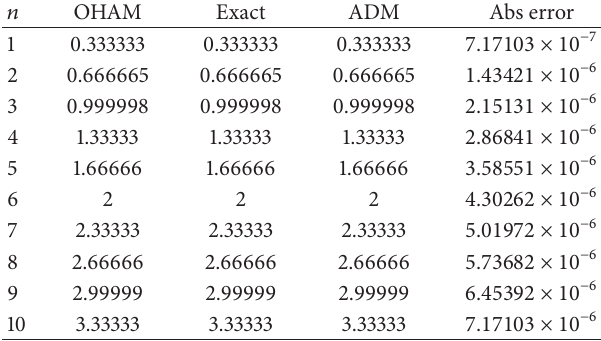
Table 1: Comparisons of OHAM, exact, and ADM results at different values of 𝑛 at 𝑡 = 1 .